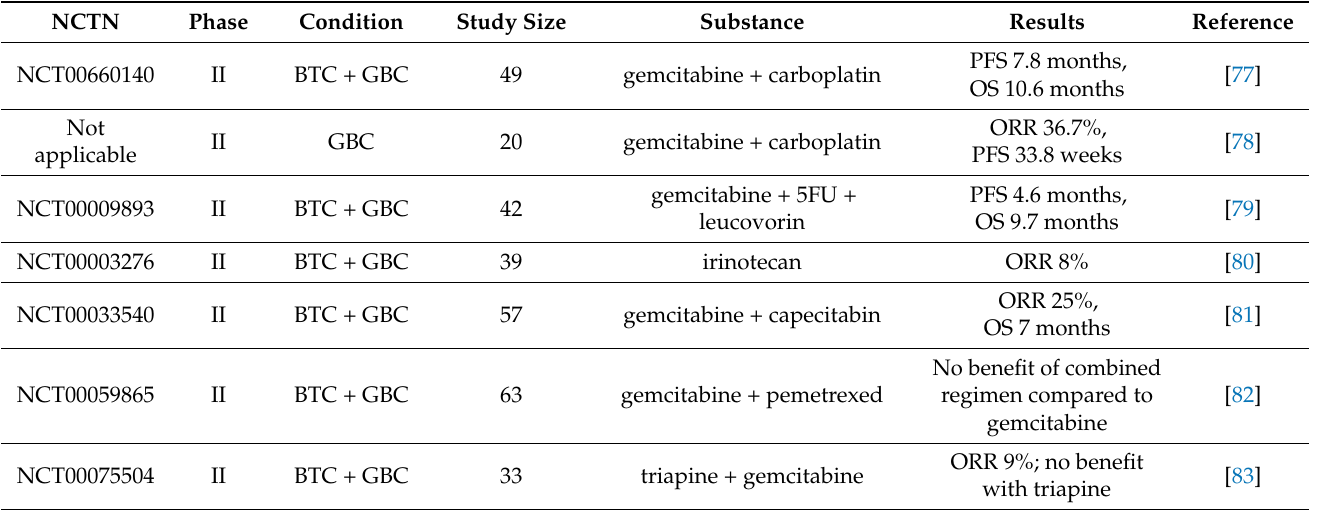
Table 2. Clinical trials for the palliative cytostatic chemotherapy of BTC specifically including GBC